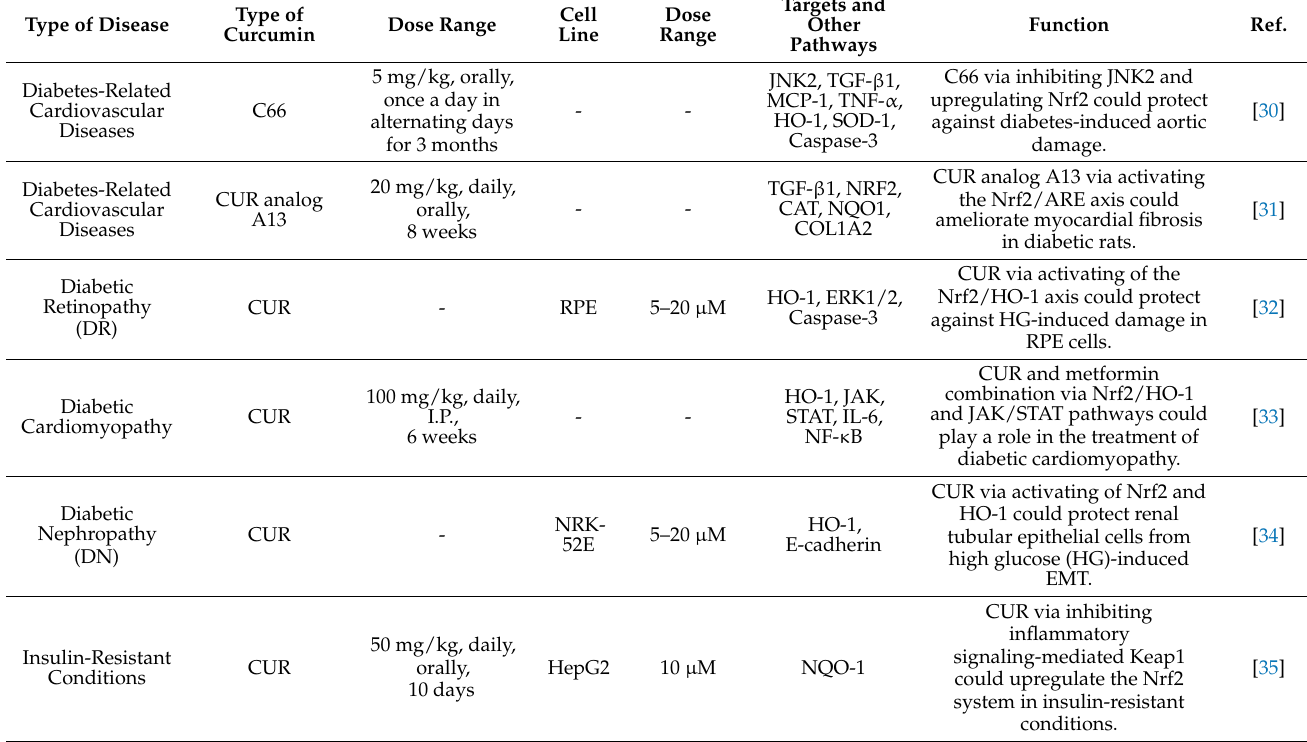
Table 3. Nrf2-related therapeutic effects of curcumin in diabetes (I.P.: intraperitoneal). Type of